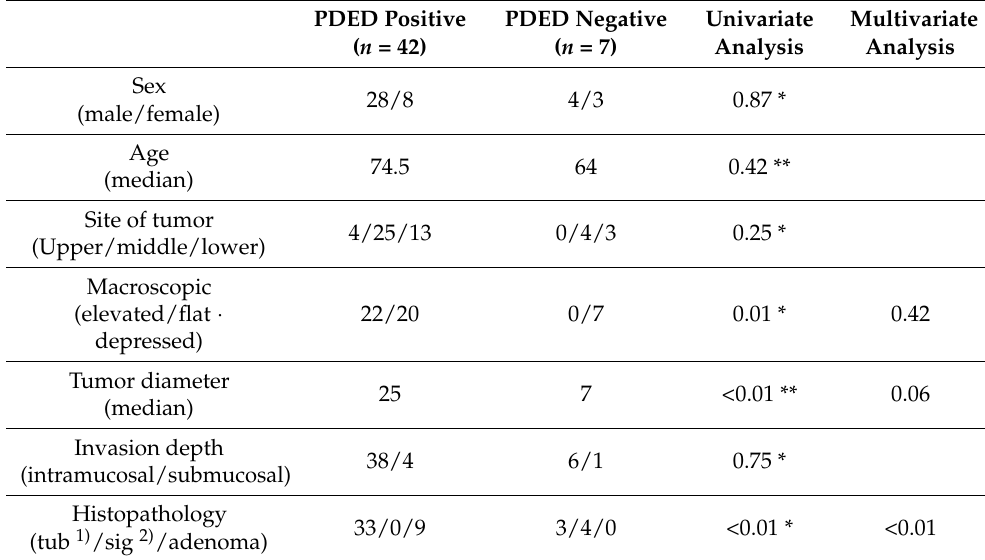
Table 1. Comparison of clinicopathological features between PDED positive and negative groups.